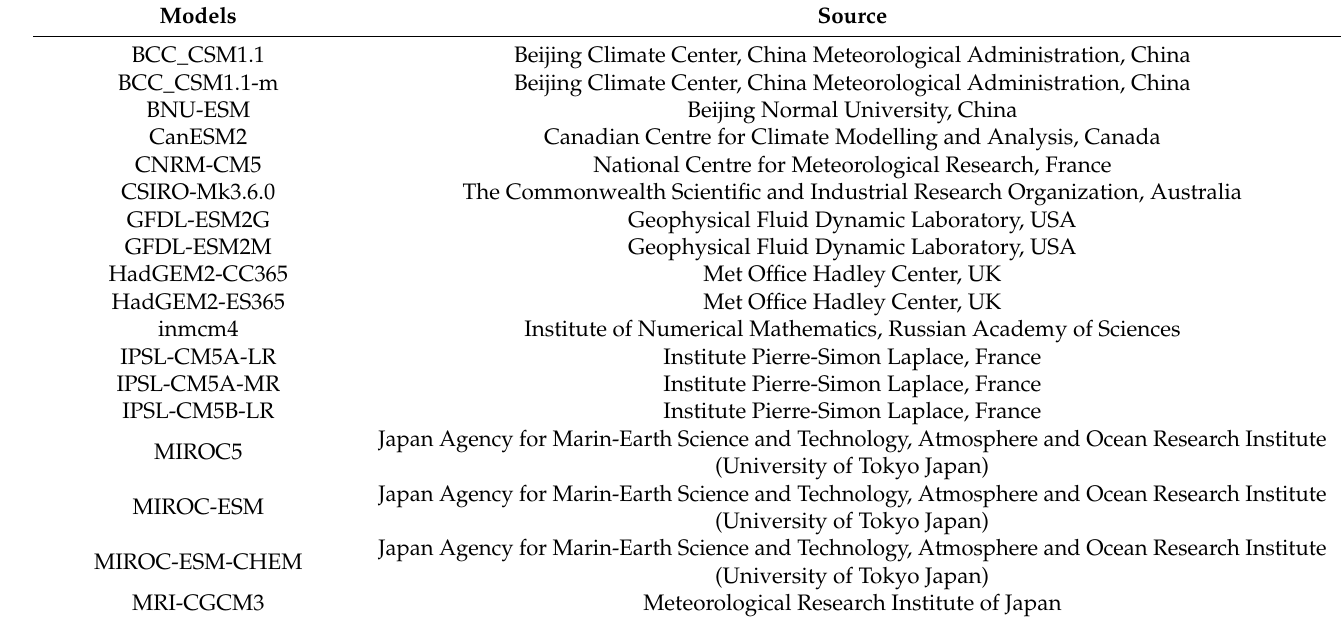
Table 1. List of global climate models and their source. Models Source BCC_CSM1.1